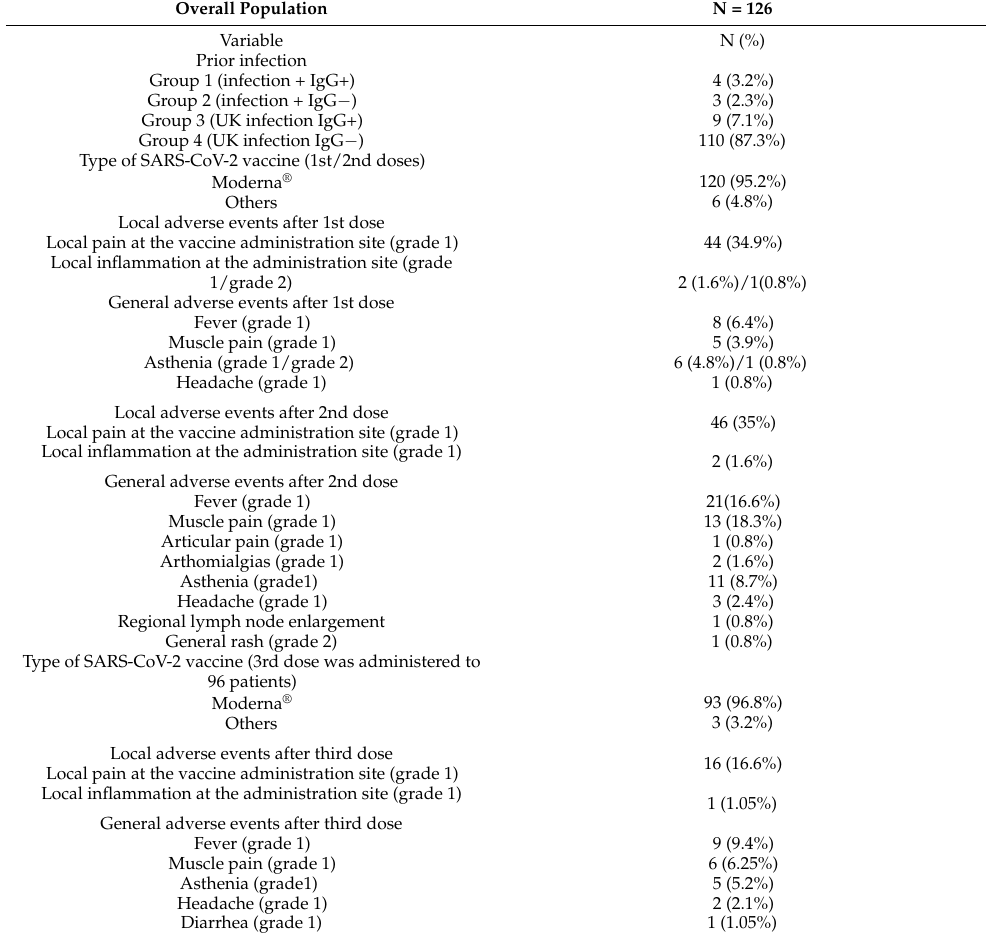
Table 2. Data regarding SARS-CoV-2 infection and vaccine-related variables of a total of 126 lung cancer patients and 19 patients ≥ 75 years old included in the study. Bold: specific information on population >75